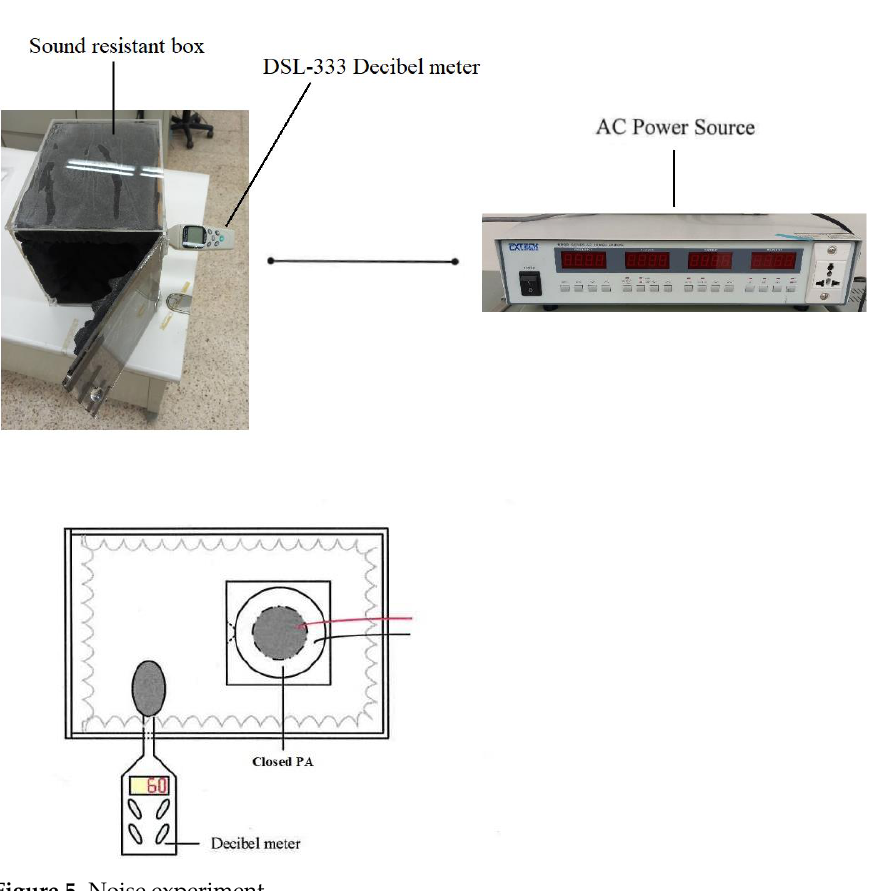
Figure 5. Noise experiment.